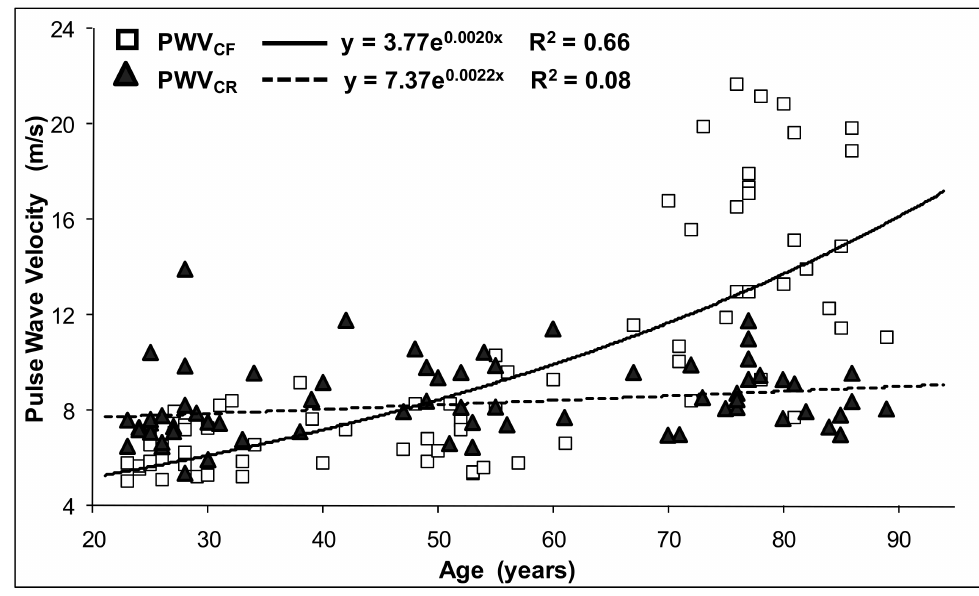
Figure 2. Relationship between age and carotid–femoral pulse wave velocity PWV CF (continuous line, open squares) and carotid–radial pulse wave velocity PWV CR (dotted line, closed triangles).